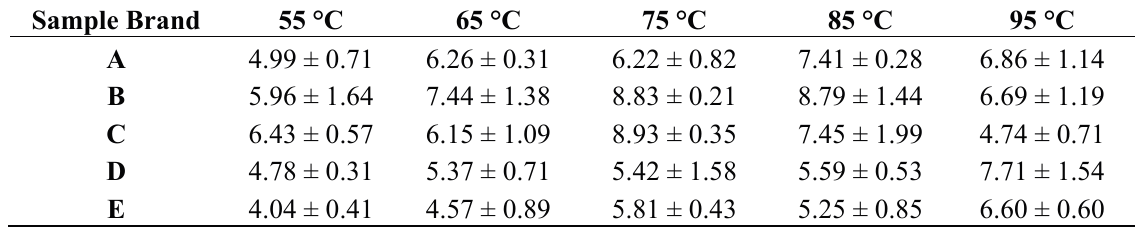
Table 5. Swelling analysis of the herbal pharmaceutical products at different temperatures. Sample